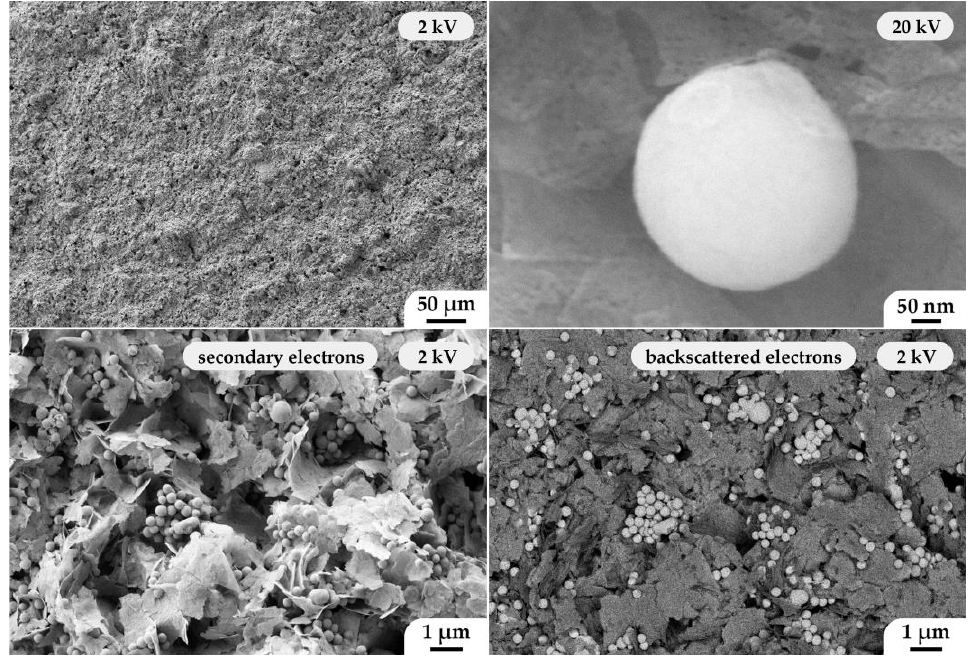
Figure 8. Microstructure of a planar composite anode of composition ((CeO 2 ) 0.8 (Sm 2 O 3 ) 0.2 )@NiO ac- cording to the SEM data. according to the SEM